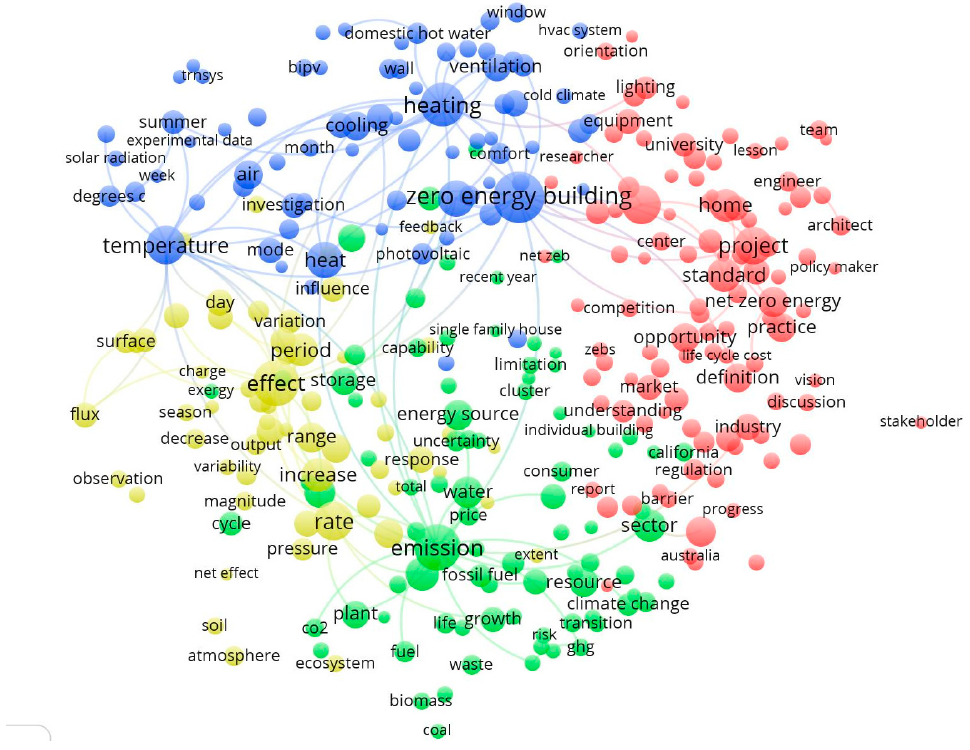
Figure 3. Term map representing the main research areas on net zero in the built environment.